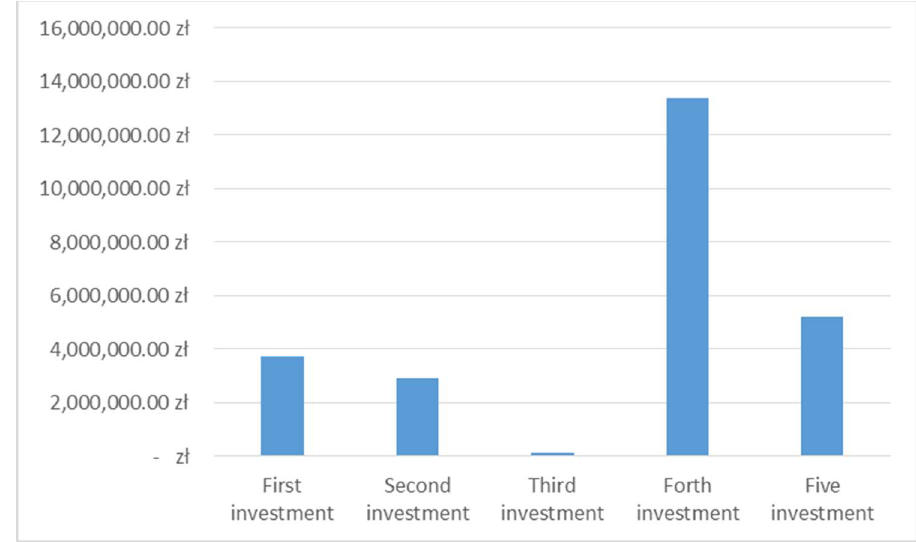
Figure 2. Costs of the pro-ecological investments in MEC Koszalin in years 2016–2020.